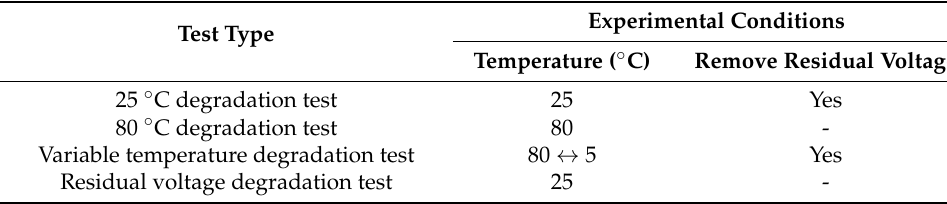
Table 5. Experimental conditions used for degradation tests.